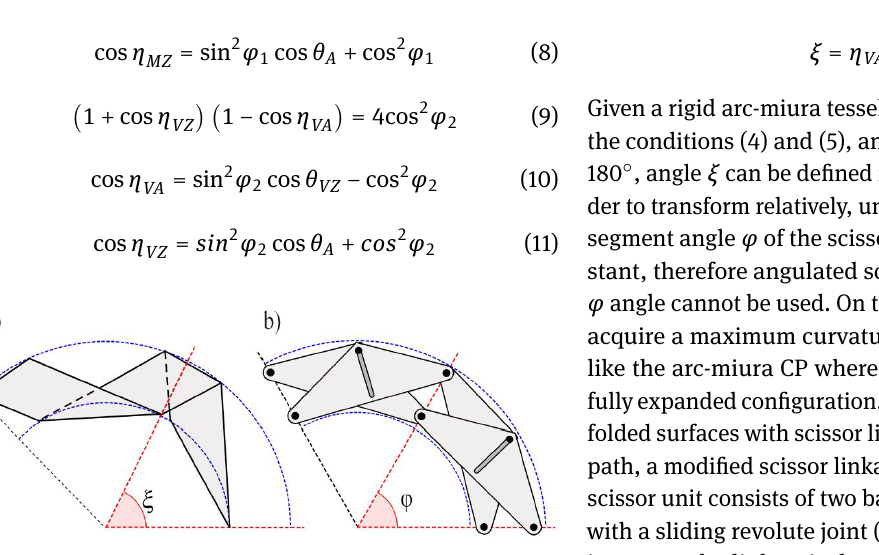
Figure 7: a) Arc-miura CP fully folded configuration b) Proposed modified scissor with sliding revolute